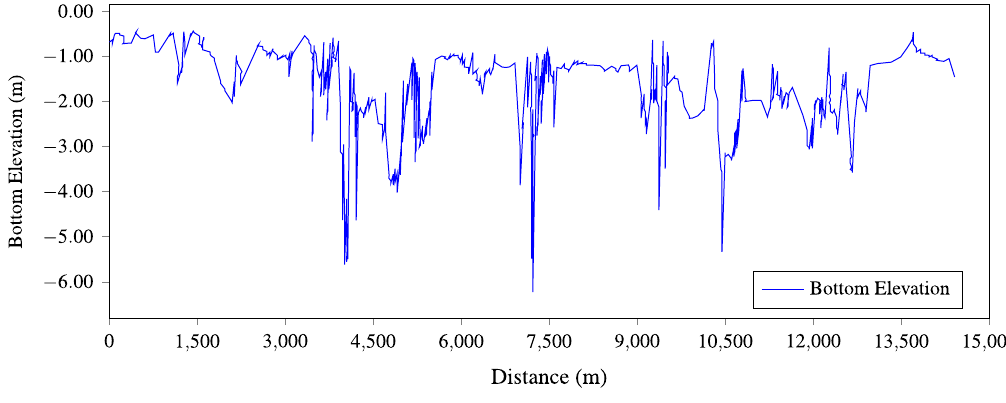
Figure 4. Bottom elevation.